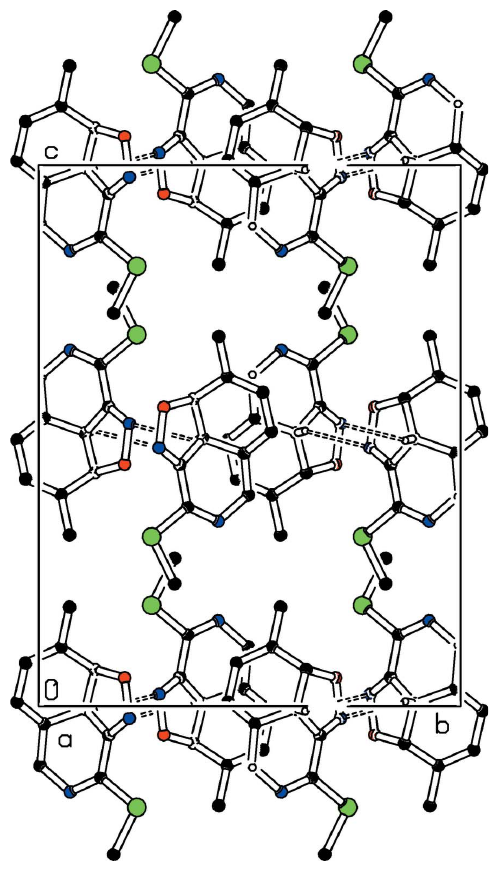
Figure 2 Part of the crystal packing of the title compound showing the formation of intermolecular C1—H1 (cid:3)(cid:3)(cid:3) N12 hydrogen bonds along the b axis. Dashed lines indicate hydrogen bond contacts. H atoms not involved in hydrogen bond interactions have been omitted for clarity.